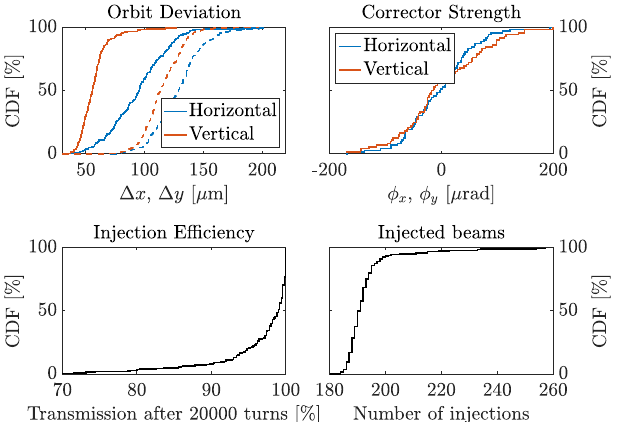
FIG. 14. Status of the machine after applying final orbit correction. The lower plots show the CDFs of the number of required beam injections (right) and the beam transmission after 20000 turns (left). The upper right plots shows the required corrector strength (right). Note that every CM and BPM in every error realization are plotted. The upper left plot shows the actual closed orbit deviation (dashed) and the corresponding BPM reading